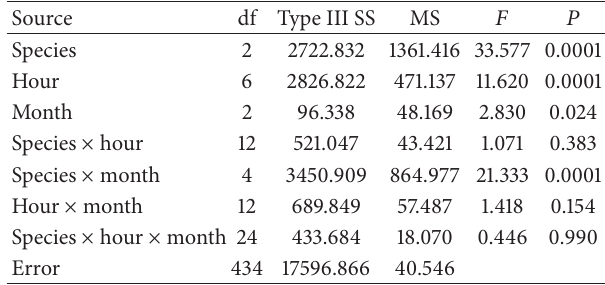
Table 3: ANOVA describing the direct and interactive effects of species (“species”), diel period (“hour”), and sampling period (“month”)onthemeanabundanceof Celithemisornata , C.elisa